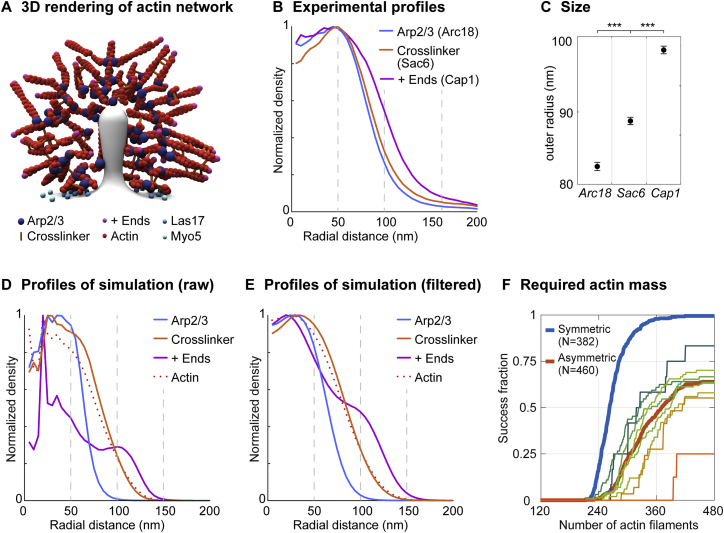
Potential Organization of Actin Filaments, Related to Figure 6(A) Illustration of a thin slice through an endocytic actin network.(B and C) The experimental radial profiles (B) and mean outer radii ± SEM of Cap1, Arc18 and Sac6 (C). These are indicating that barbed ends (Cap1) protrude further outward than pointed ends (Arc18). Crosslinker (Sac6) had an intermediate size, consistent with a cross-linking function between the middles of the filaments (Skau et al., 2011).(D and E) This organization is recapitulated in the raw (D) and filtered (E) average profiles from Cytosim simulations. Profiles in (E) were calculated from (D) by blurring the raw coordinates from the simulations by 15 nm to simulate the localization precision of superresolution imaging.(F) Comparison how many actin filaments are needed to reach a certain invagination depth in symmetric and asymmetric nucleation. ∗∗∗p < 0.001 from Wilcoxon rank-sum test.